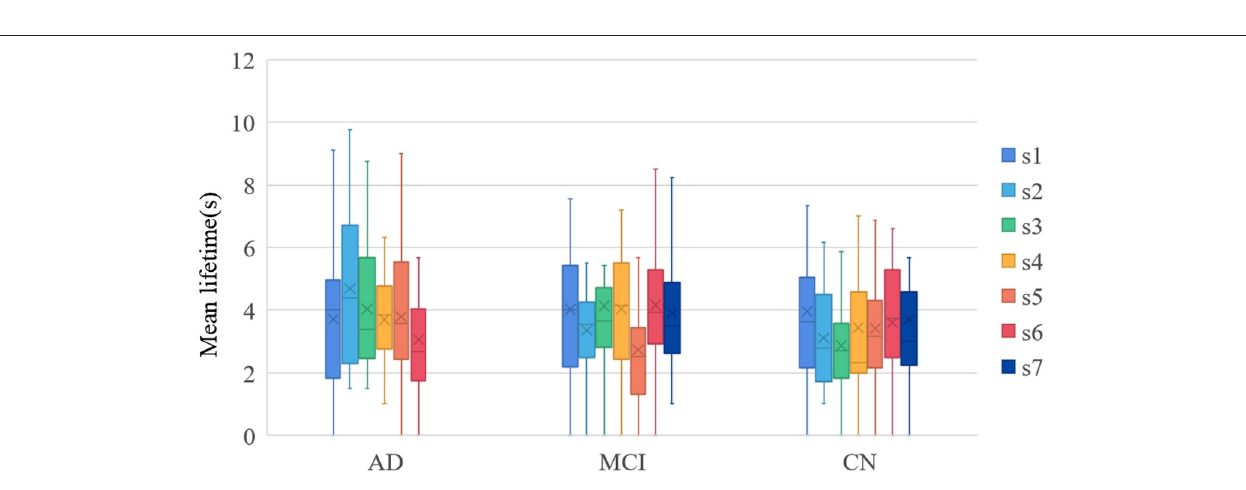
FIGURE 5 | Mean lifetimes of dBS. s1 ∼ s7 were state 1 ∼ state